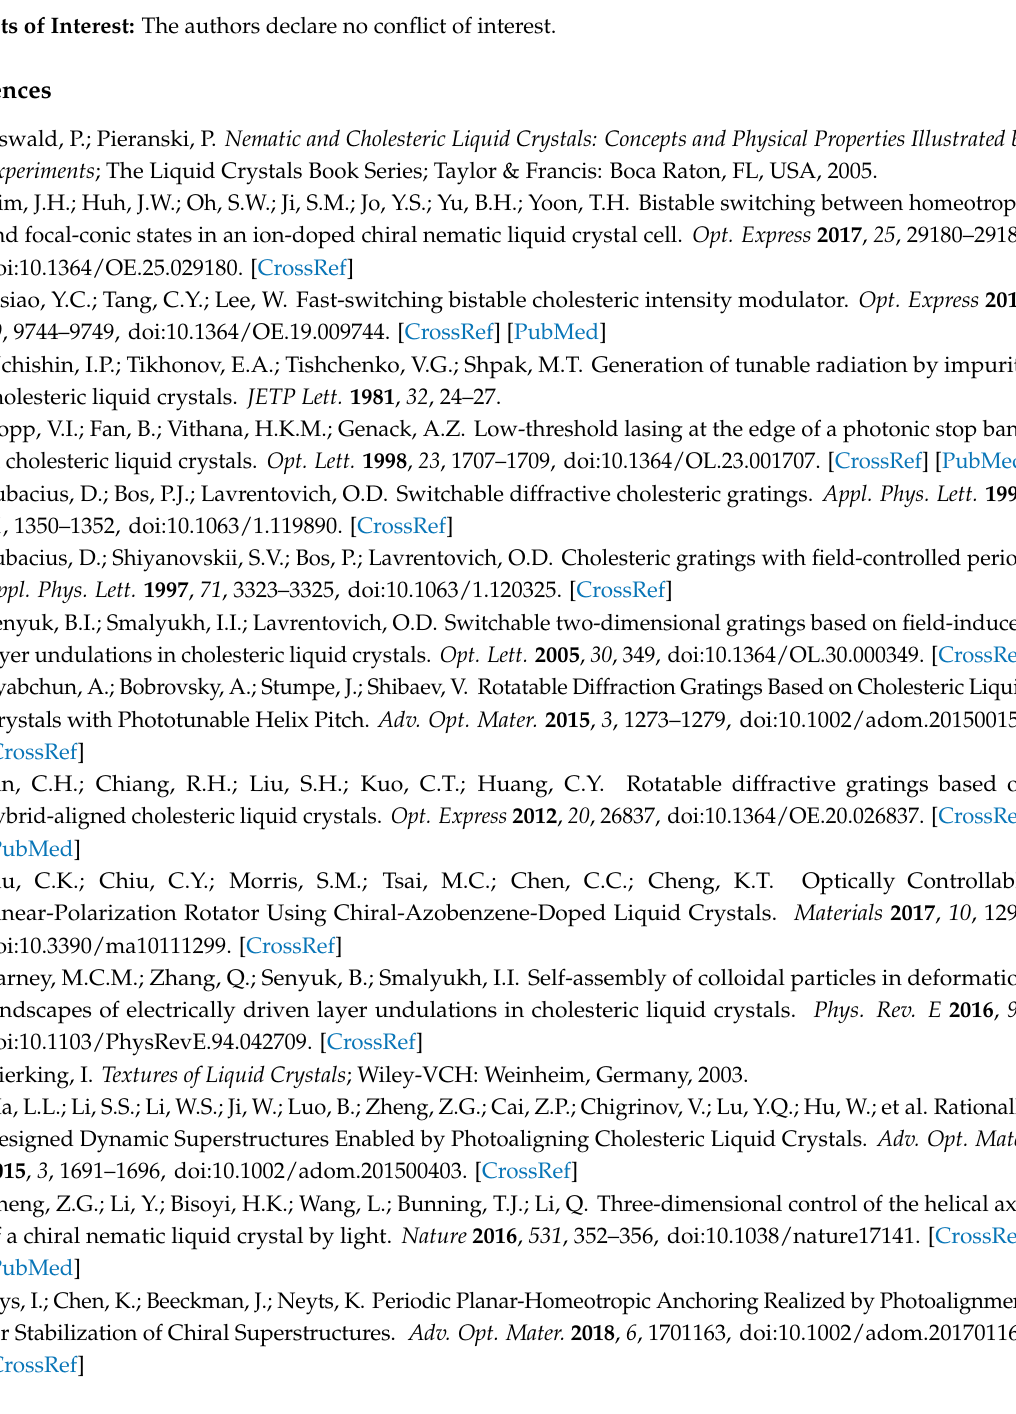
Figure S1. POM photos of nematic layer taken using polarized light. The angle between rubbing direction of PVA film and polarizer is 0 ◦ ( a ), 45 ◦ ( b ) and 90 ◦ ( c ). The polarizer direction is indicated by the double arrow and the single arrow is the rubbing direction of PVA film, Figure S2. POM photos of cholesteric layer with confinement ratio d/p = 0.44 are taken using the interference filter (l = 602 nm). The angle between analyzer and rubbing direction of PVA film is − 10 ◦ ( a ), − 40 ◦ ( b ), − 70 ◦ ( c ), 20 ◦ ( d ), 50 ◦ ( e ), 70 ◦ ( f ). Polarizer is perpendicular to the rubbing direction. LC layer thickness is 6.5